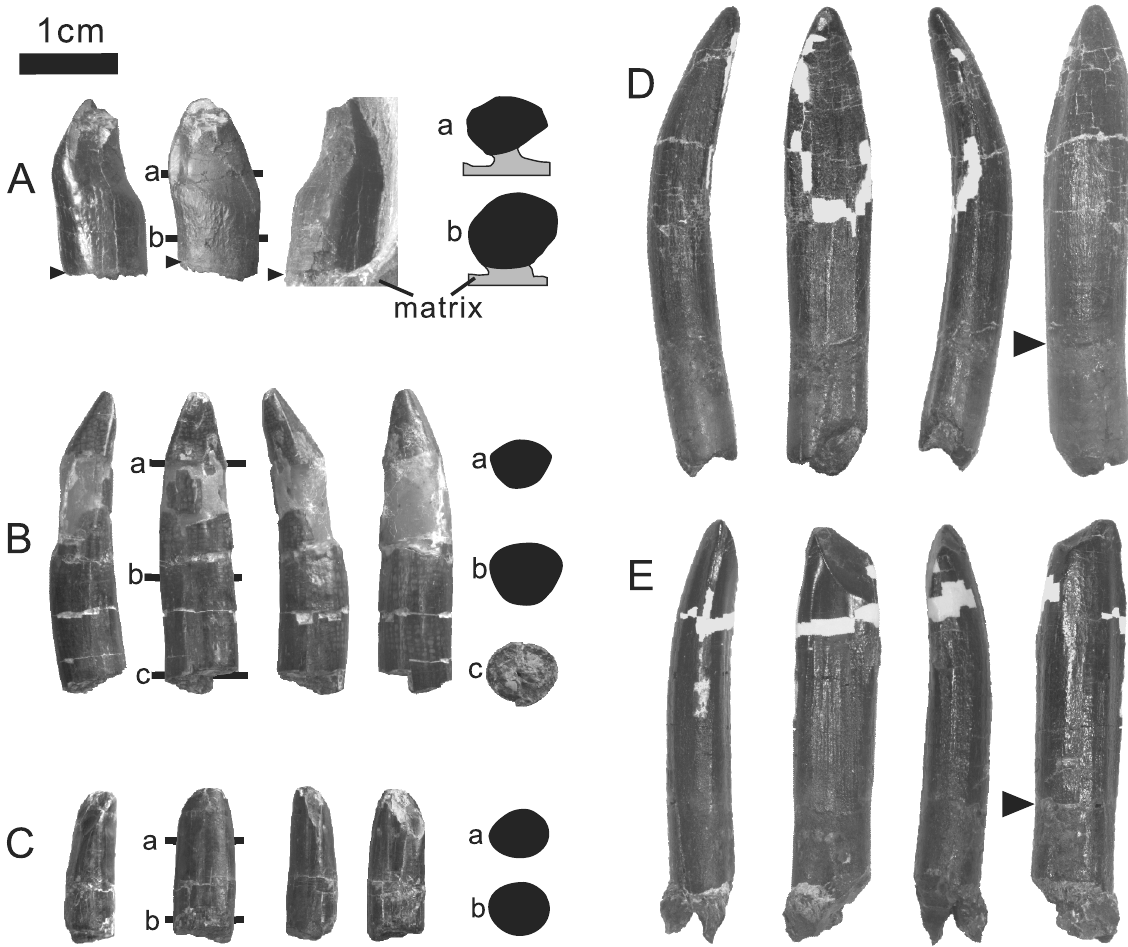
Fig. 2 – Sauropod teeth from Japan. A: Sauropod tooth from the Matsuo Group (the Toba sauropod tooth); B and C: Sauropod teeth from the Futaba Group (the Kohisa specimens), IMCF no. 959 and 1122, respectively; D and E: Sauropod teeth from the Sasayama Group (the Tamba sauropod). In A, the three photos from left to right are in mesial, lingual, and distal views, respectively. In B through E, the four photos from left to right are “mesial”, “lingual”, “distal”, and “buccal” views, respectively. In A, D, and E, a solid triangle indicates the position of the cervix. In A to C, silhouettes and photos arranged from top to bottom on the right side are horizontal cross sections of the tooth, and their positions are indicated by horizontal lines with small letters a, b, and c. In horizontal cross sections of A to C, lingual is to the top, and distal is to the right of the page.